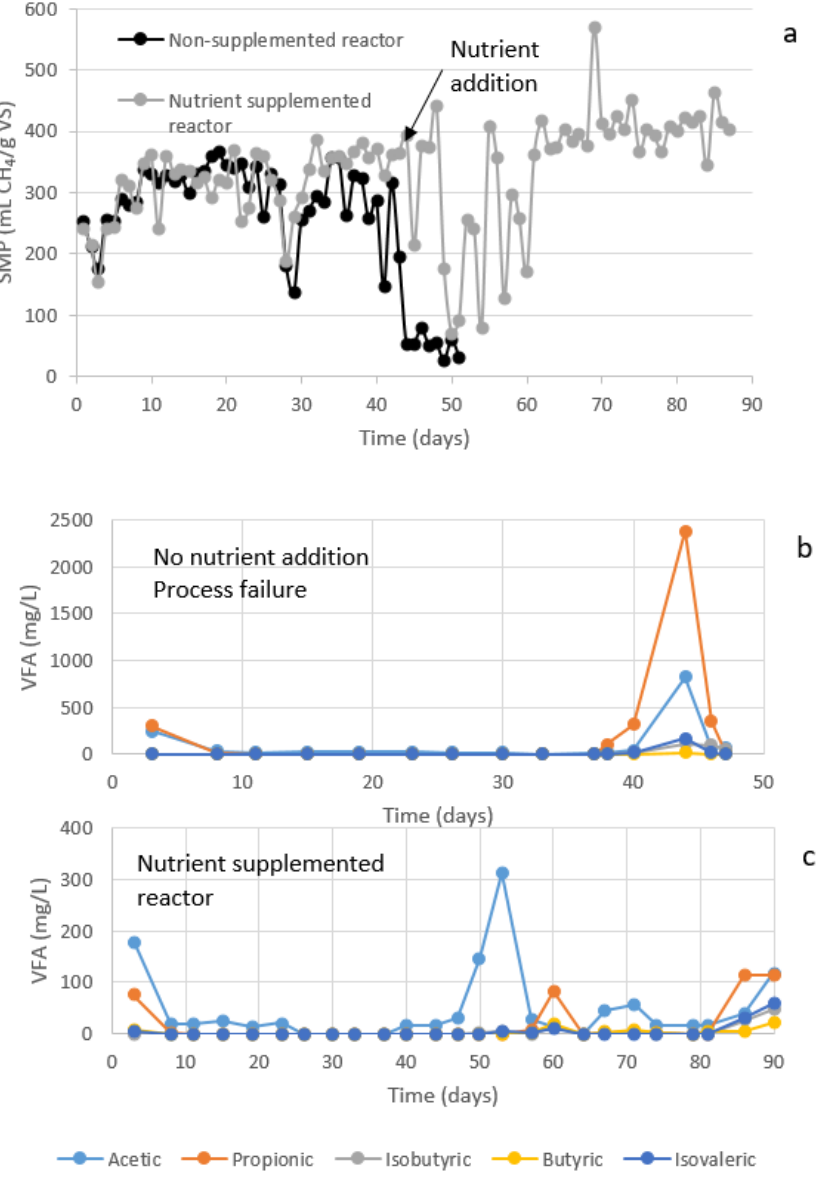
Figure 2. ( a ) Specific methane production (SMP) from reactors treating fourth-range wastes. Two reactors shown, one with nutrient supplementation and the other one lacking nutrient addition (failure system). ( b ) Volatile fatty acid (VFA) evolution for failure system. ( c ) VFA evolution for nutrient-supplemented reactor.